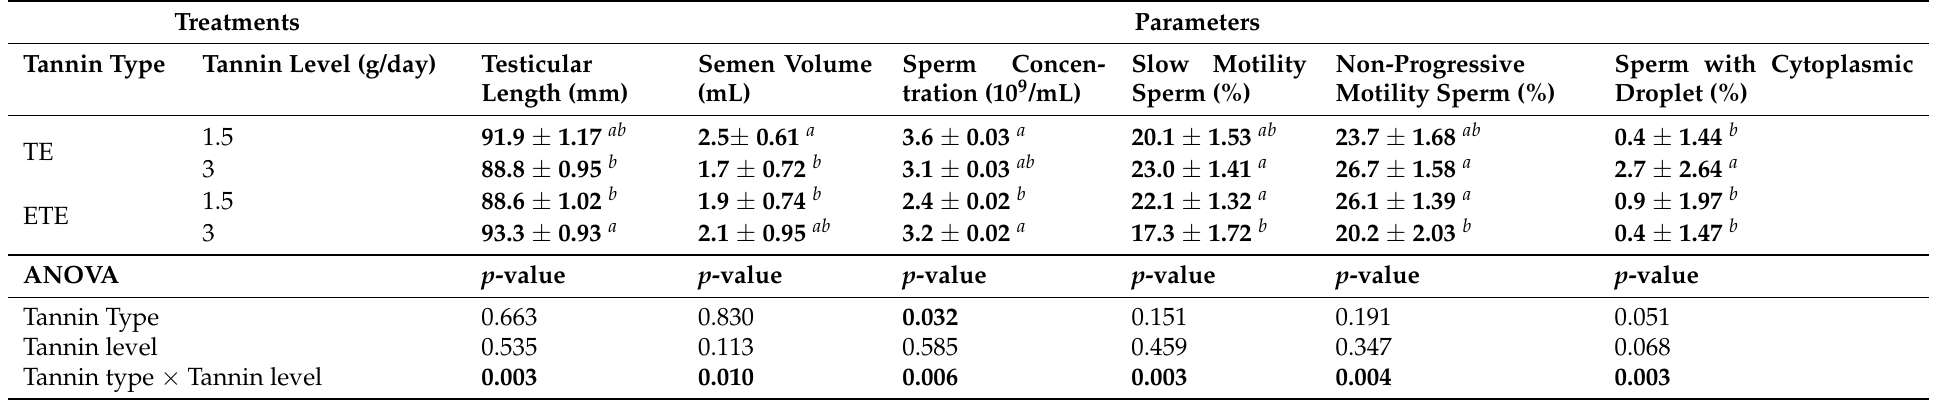
Table 4. Effects of tannin type and tannin supplementation level on the testicular length and some semen quality parameters of Merino rams (Mean ± SE).